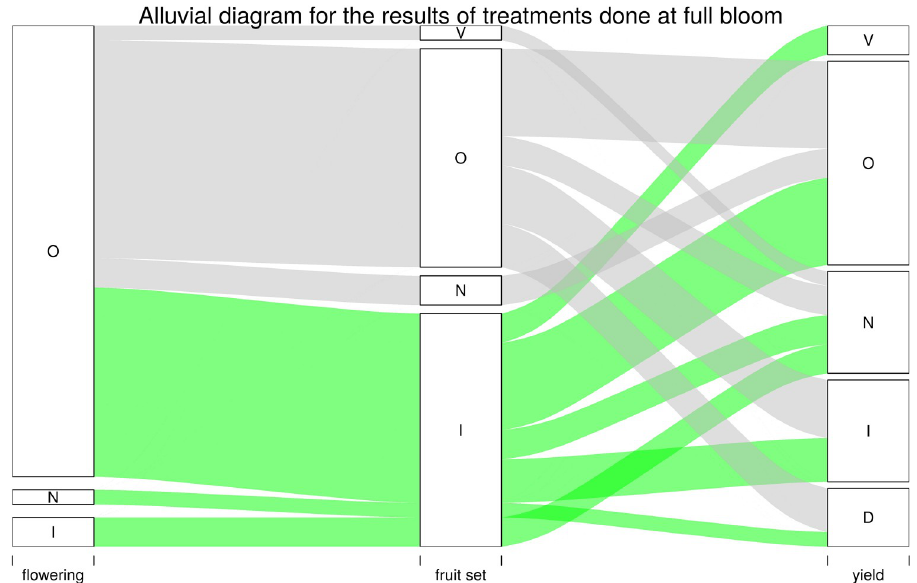
Fig 9. Alluvial diagram for the results of treatments done at full bloom or some weeks later. Only the studies with treatments at full bloom or some weeks later were considered. The effect of GA at full bloom on flowering, fruit set and yield for each reviewed publication was noted as follows: N, no effect; I, increase; D, decrease; O, not studied and V, variable results. Bandwidth reflects the number of publications. The narrowest bandwidth represents a single publication. Green denotes the articles in which GA increased fruit set, while gray denotes the articles in which GA had a different effect.